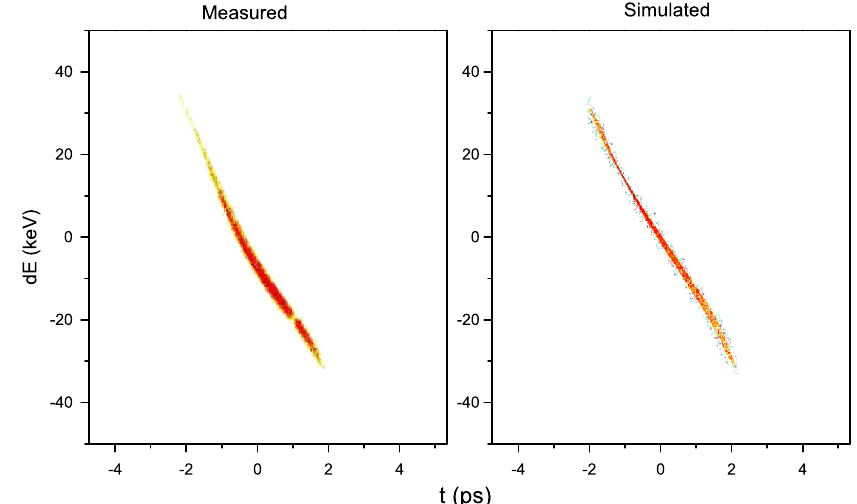
FIG. 8. (Color) An example of nonlinearity in the longitudinal phase space. The measured LPS is shown on the left while the GPT simulated LPS is shown on the right. The nonlinearity in the LPS can be attributed to asymmetry in the beam caused by image charges due to high charge density at the cathode. These shots were taken with a charge of 20 pC and an rms transverse spot size at the cathode of (cid:8) l ¼ 130 (cid:1) m